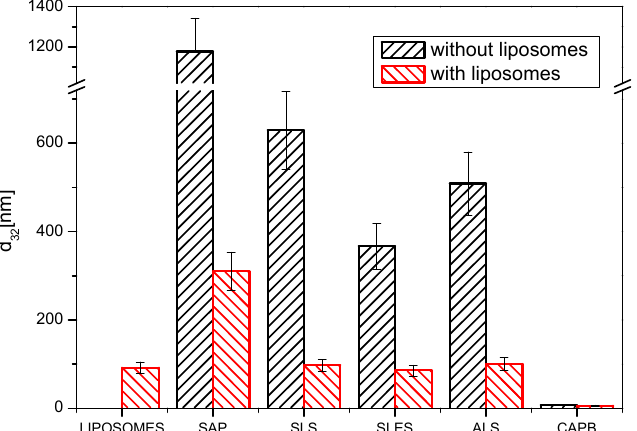
Figure 4. Sauter mean diameter values (d 32 ) of the soapwort extract or synthetic surfactants (SLS, SLES, ALS, CPB), 5% concentration of the dry weight in the absence and presence of DPPC/cholesterol (7:3, mol/mol) liposomes, 2 h after preparation. The results for bare liposomes in buffer (in the absence of any (bio)surfactant) are also shown for comparison. All measurements performed at room temperature.